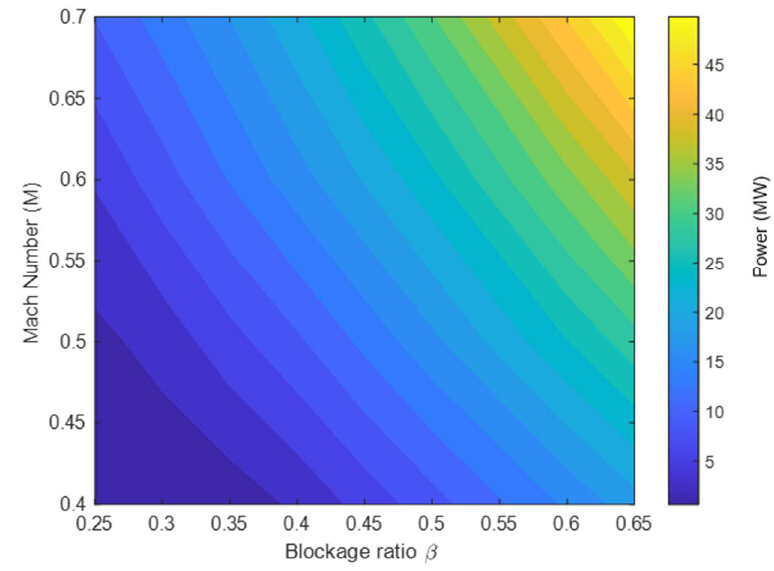
Figure 7. Power contours correlating blockage ratio β and Mach number, p = 10 kPa.